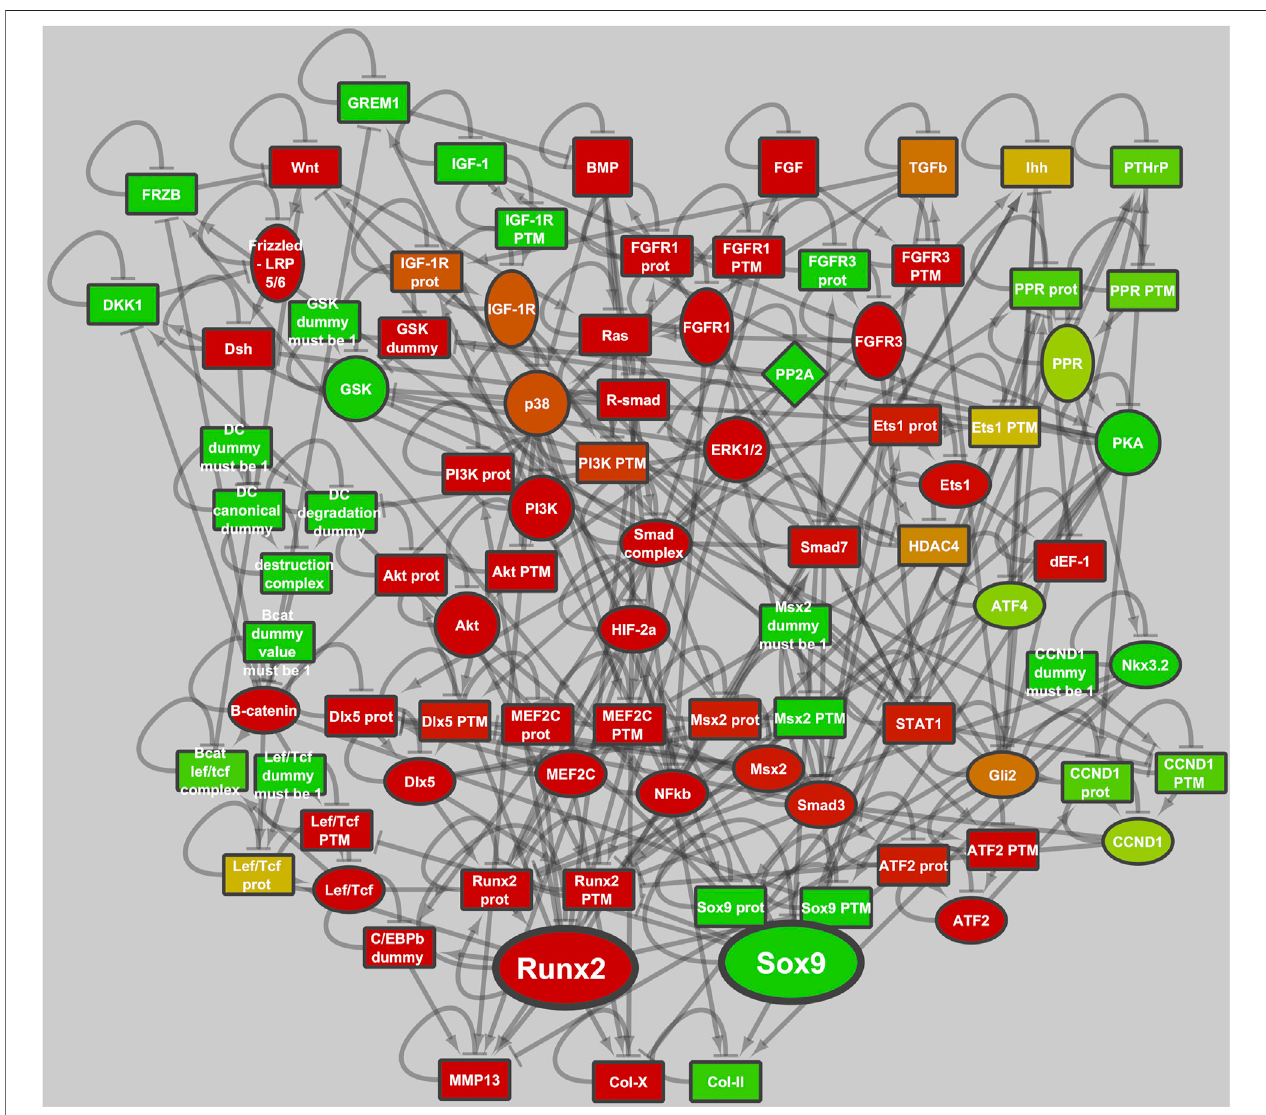
FIGURE 2 | ECHO, executable chondrocyte, describes the development and maintenance of articular chondrocytes. The activities of the transcription factors SOX9 and RUNX2 are regulated by an intricate network of signal transduction pathways, including IHH, PTHrP, FGF, WNT, BMP, TGF β , HIF and IGF. The model is depicted in the SOX9+ state and node. Activity is represented on a scale from red (inactive) via yellow to green (active).